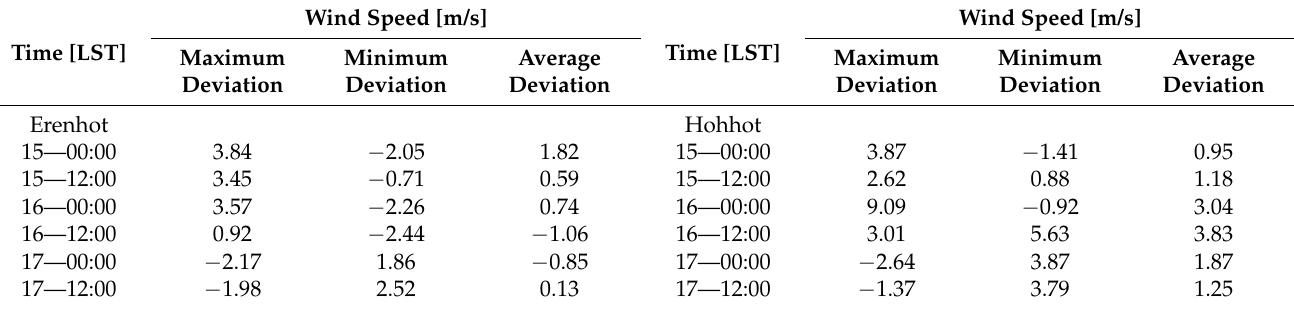
Table 3. Statistical biases of mean wind speed above the main landing area in the “Shen Zhou 6” case.